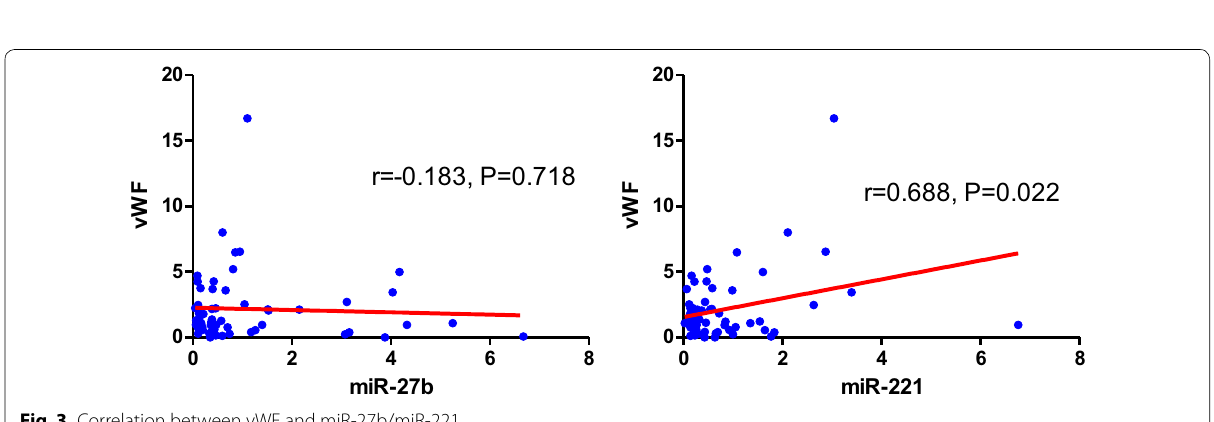
Fig. 3 Correlation between vWF and